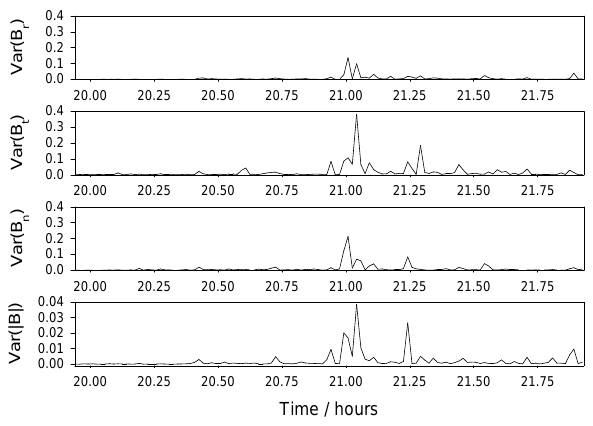
Fig. 7. Magnetic field variance in 3 components and magnitude (4 panels) using bins of 60s of data for shock on day 326, 1996. The three components are in the standard heliospheric r, t, n coordinate system.